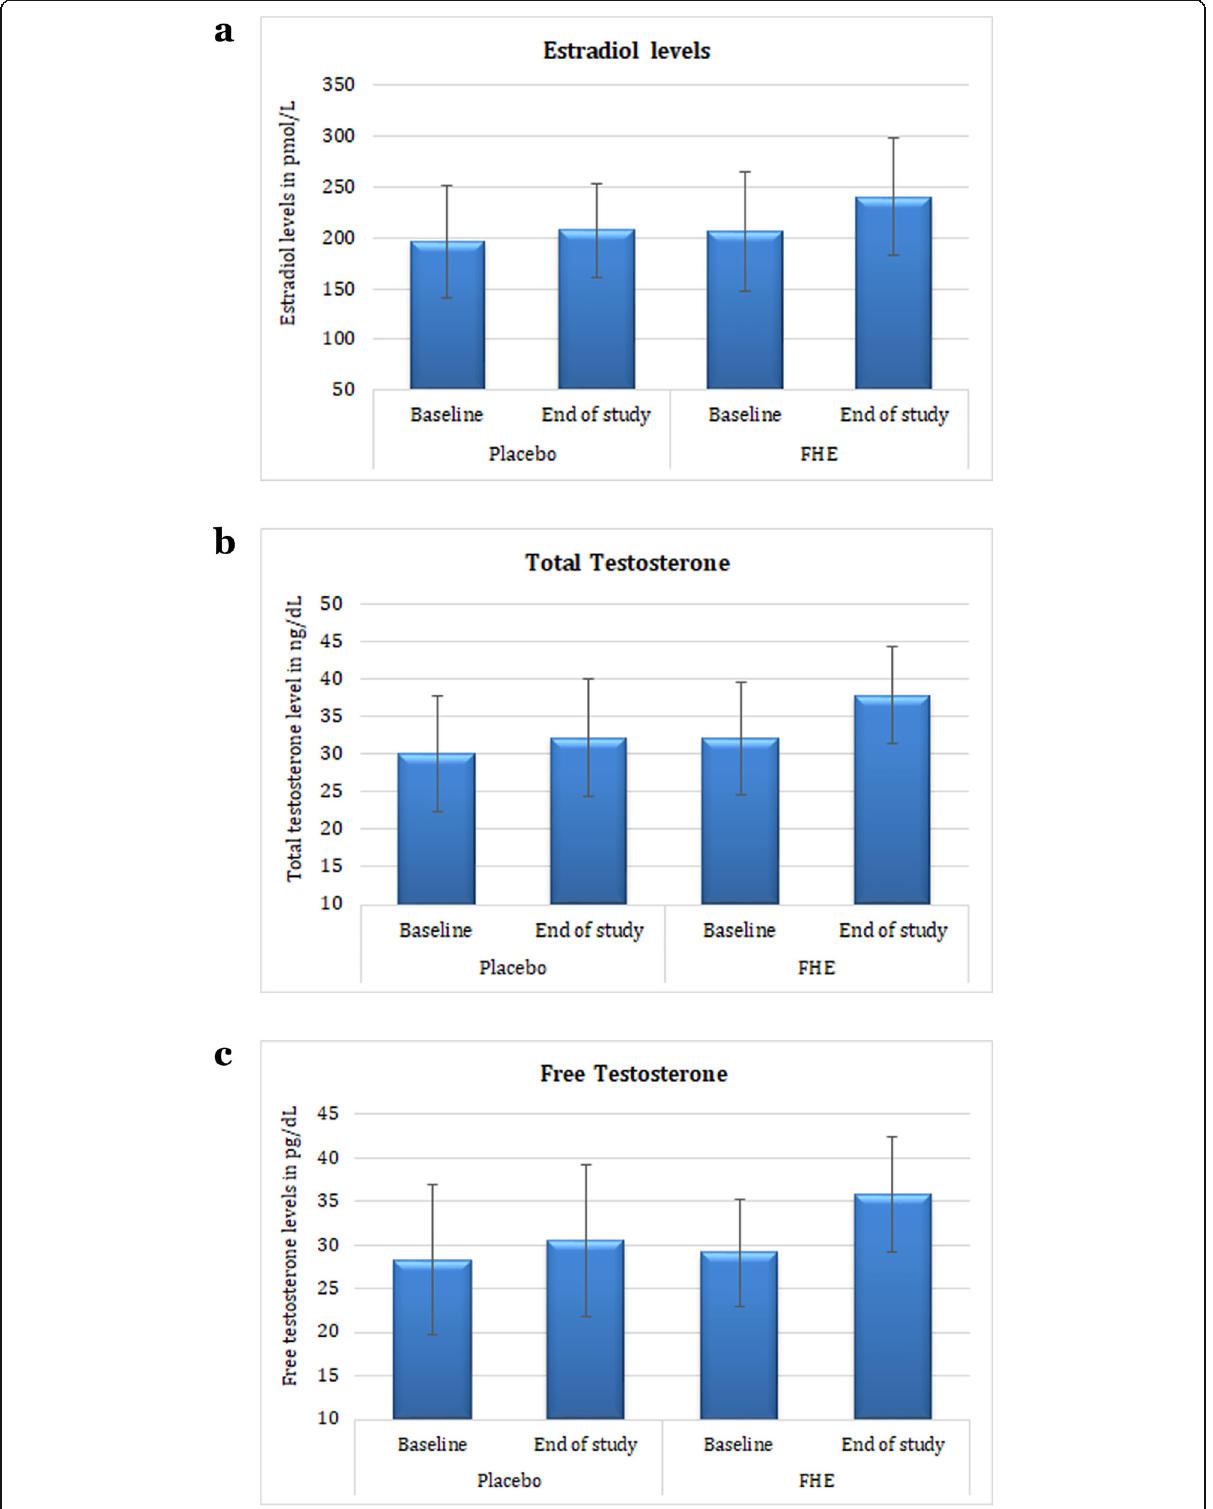
Fig. 4 Changes in the levels of ( a ) Estradiol ( b ) Total testosterone and ( c ) Free testosterone in FHE and placebo group at baseline and day